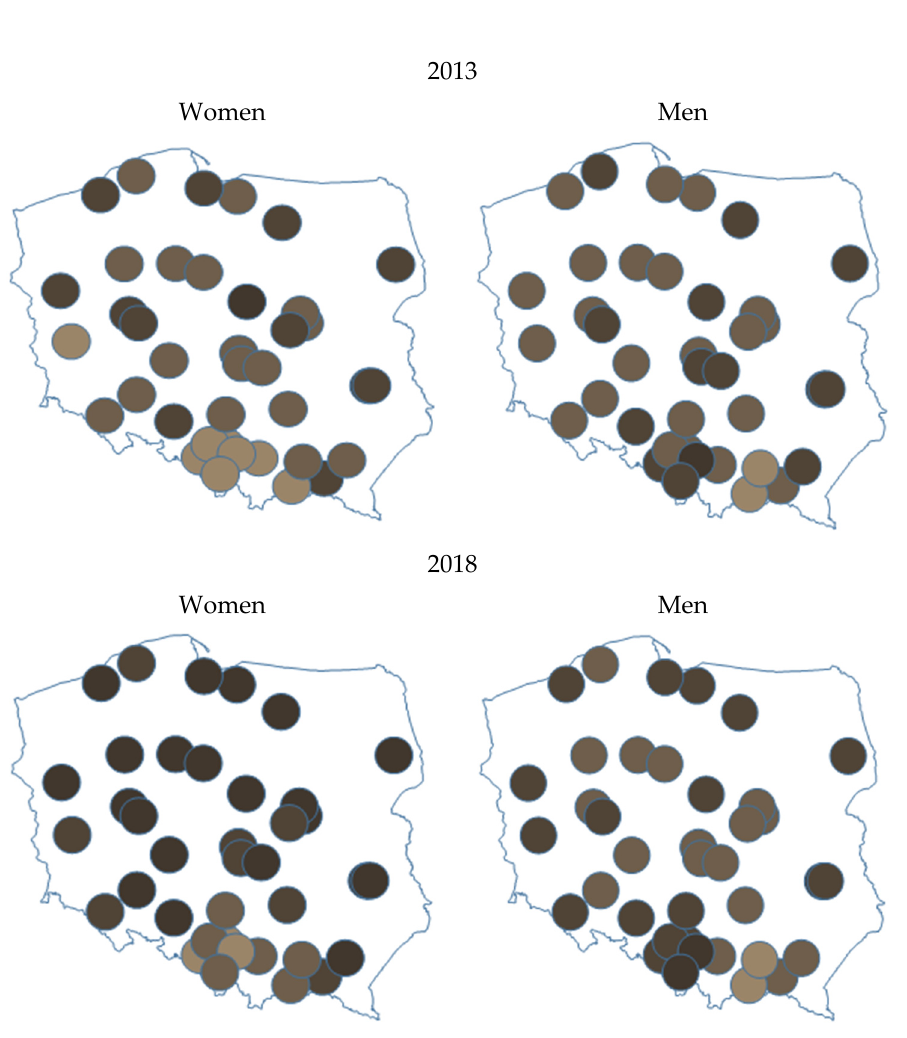
Figure 1. Geographical differentiation of the relationship between income and life expectancy in Poland. Source: authors’ own study (using CONT-EVO MAP).